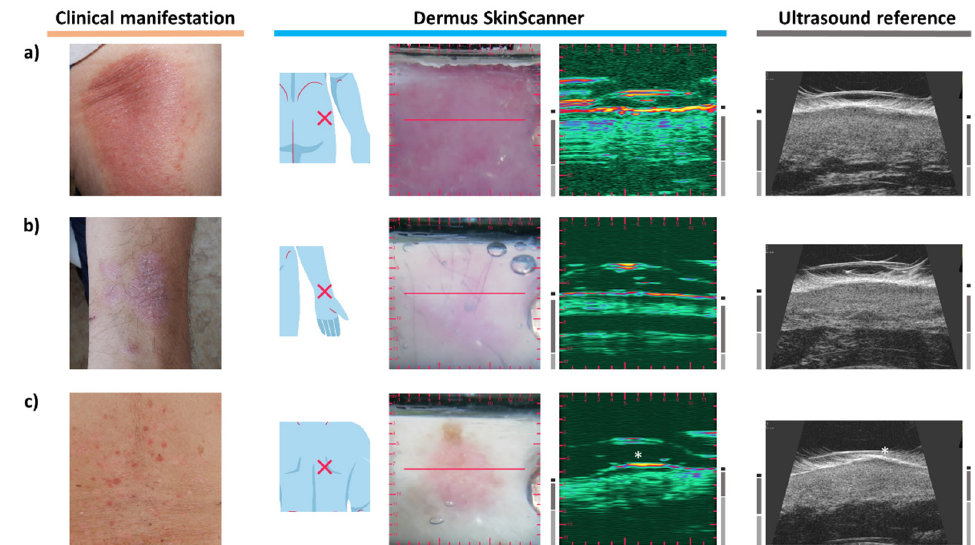
Figure 10. Examination images of psoriasis skin lesions (see Figure 2 for figure layout and marking information). ( a ) The ultrasound images show a clearly visible Subepidermal Low Echogenic Band (SLEB) as well as a relatively high thickness of the dermis (as signs of inflammation). ( b ) The ultrasound images show a clearly visible SLEB and a relatively thick dermis. Note the vessel-like hypoechoic structure in the dermis visualized in a parallel orientation to the image plane. ( c ) Guttate psoriasis. A SLEB with a relatively small lateral extent (compared to those of Figures 9a and 10a,b) is shown on the ultrasound images.